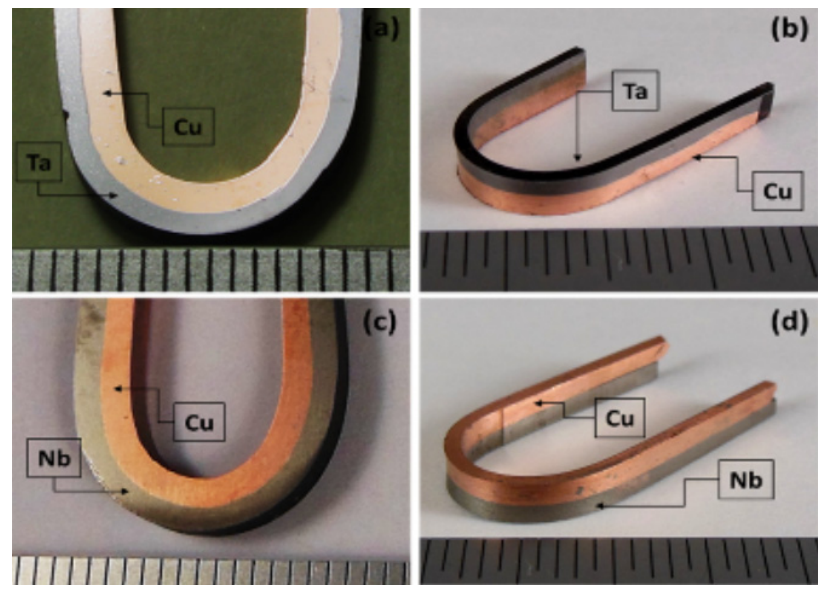
Figure 20. Copper coating on different materials. ( a , b ) On tantalum. ( c , d ) On niobium [66]. 5. Perspective